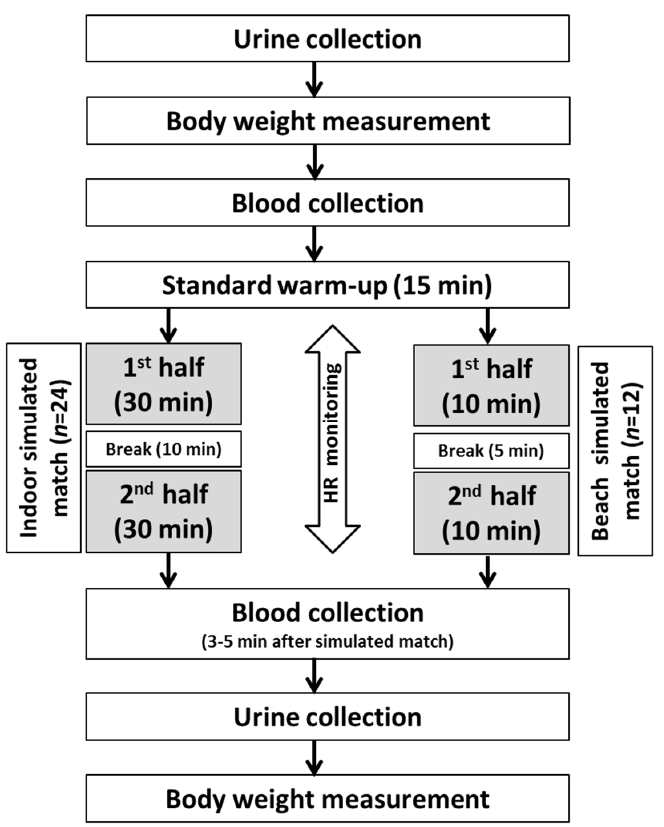
Figure 1. Pattern of testing for handball players playing indoors and on the beach.